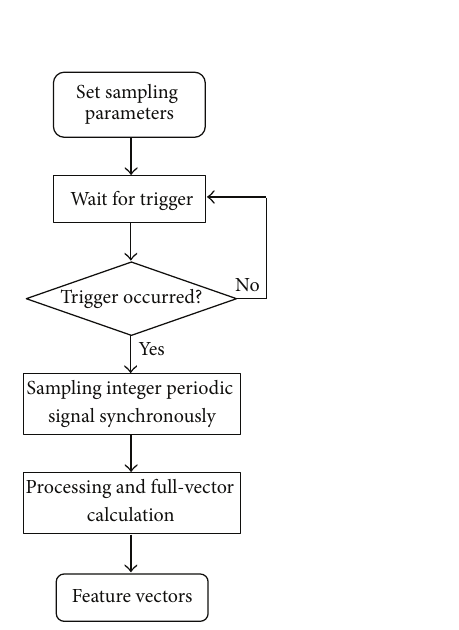
Figure 4: Structure of full-vector data acquisition.